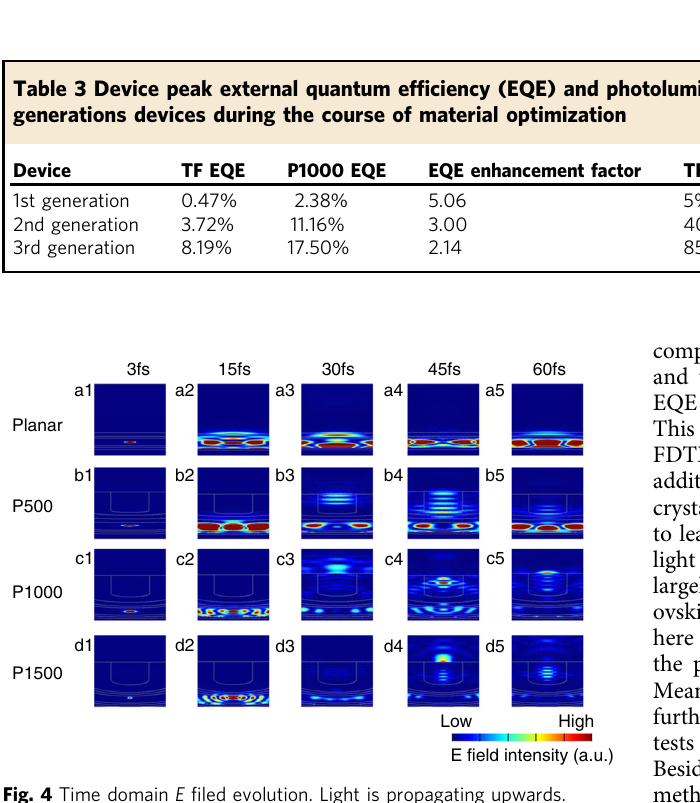
Fig. 4 Time domain E fi led evolution. Light is propagating upwards. Different rows correspond to different structures. From top to bottom: a1 – 5 planar, b1 – 5 P500 AAM, c1 – 5 P1000 AAM and d1 – 5 P1500 AAM. Different columns correspond to different moments when the light propagates (from left to right: 3 fs, 15 fs, 30 fs, 45 fs, and 60